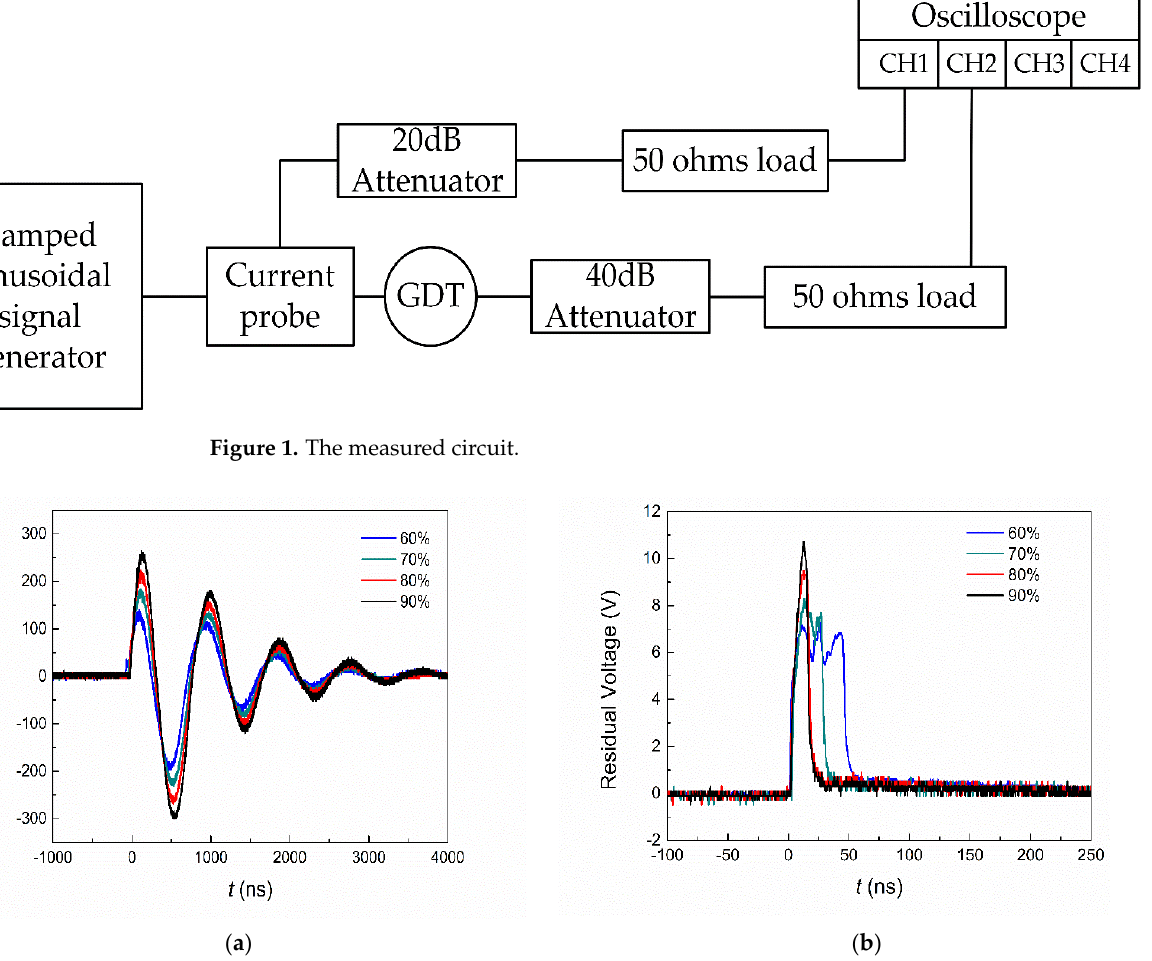
Figure 2. The typical waveforms of inject current and residual voltage of 1 MHz. ( a ) Different lev ‐ els of damped sinusoidal signal injected; ( b ) Residual voltage at different levels. of damped sinusoidal signal injected; ( b ) Residual voltage at different